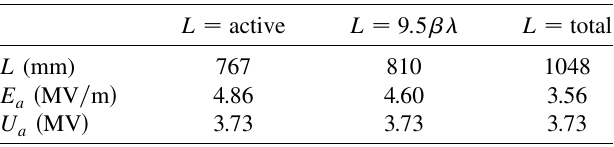
TABLE II. Different length and gradient definitions in the CH cavity.